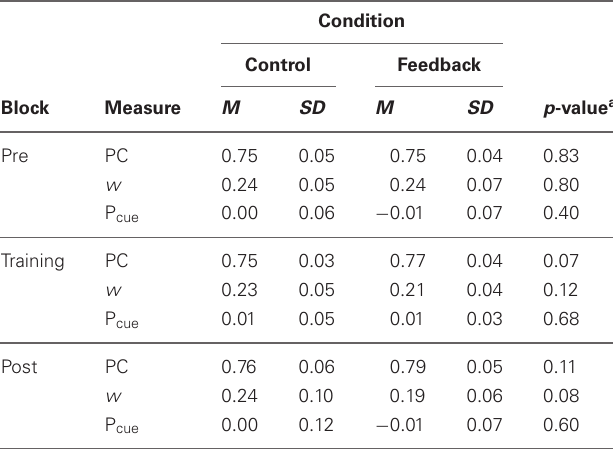
Table 1 | Performance, both as w and PC, in each part of the experiment (pre-test, training, post-test) and the P cue index for the control and feedback conditions respectively.